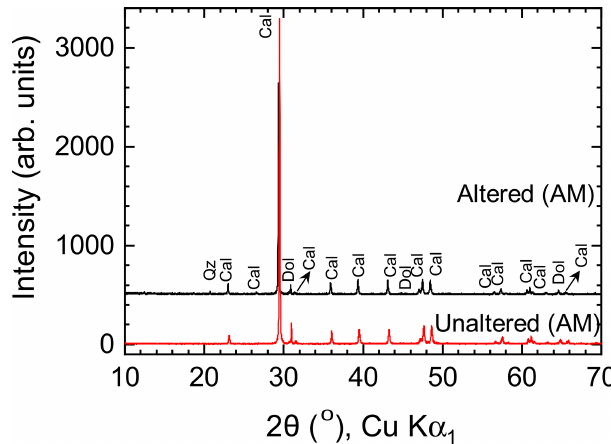
Figure 3. Powder XRD patterns of the altered and unaltered zones of marble from Asia Minor (Turkey). Cal, Dol, and Qz mark the Bragg peaks arising from calcite, dolomite, and quartz,